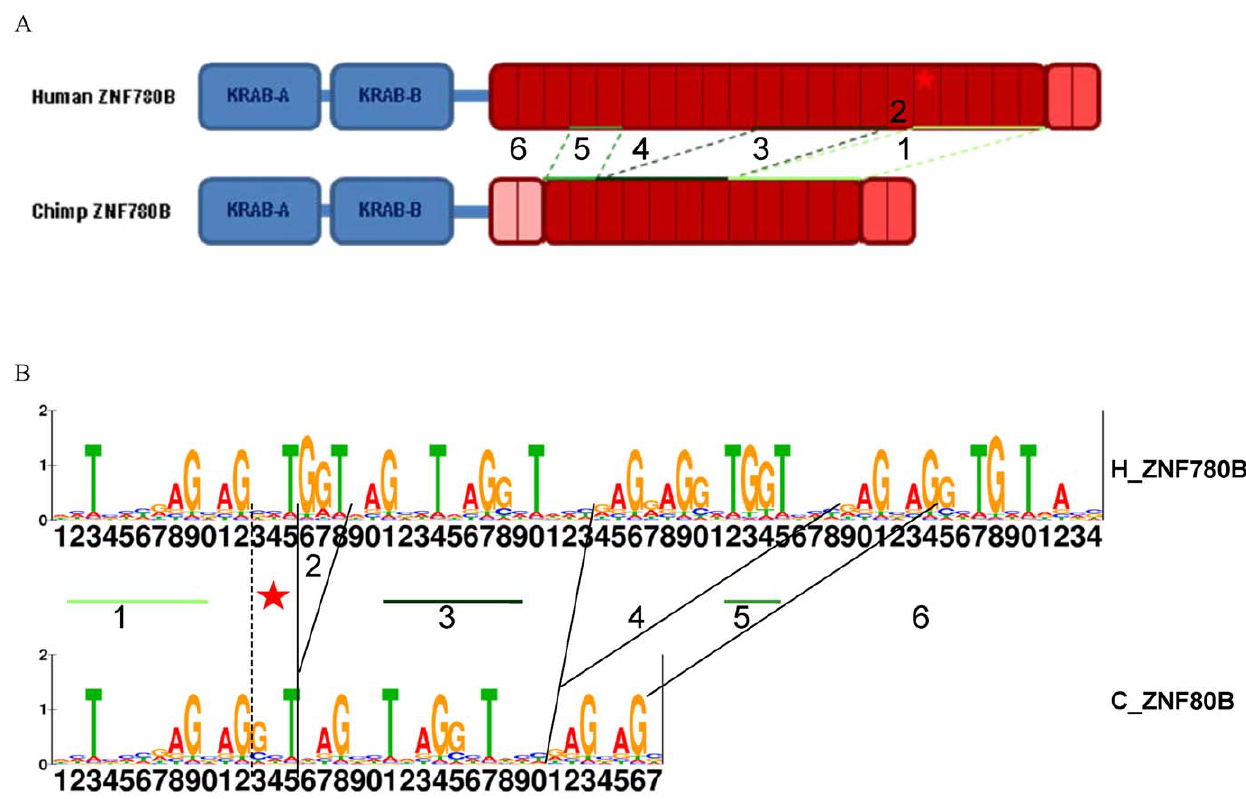
Figure 4. Sequence and predicted binding motif differences between human and chimpanzee ZNF780B. A. Both proteins contain a KRAB-A, a KRAB-B, and a polydactyl ZNF domain. The last two ZNF motifs are not functional in both species due to mutations of the Histidine residues preventing the correct folding of the binding domain. The first two ZNF motifs of the chimpanzee gene are not included in the protein. Homologous ZNF motifs are indicated by green lines. The first three, the 6 th to 10 th , as well as the 16 th ZNF motif are deleted in chimpanzee ZNF780B. The human ZNF780B protein is characterized by a human-specific amino acid at position 6 in the 17 th ZNF motif, indicated by a star. B: Binding motifs for human and chimpanzee ZNF780B as predicted by the tool developed by Kaplan and colleagues (28). Corresponding stretches of the binding motif and ZNF domains are indicated by numbers, the star, and green lines, respectively. doi:10.1371/journal.pone.0021553.g004 PLoS ONE |